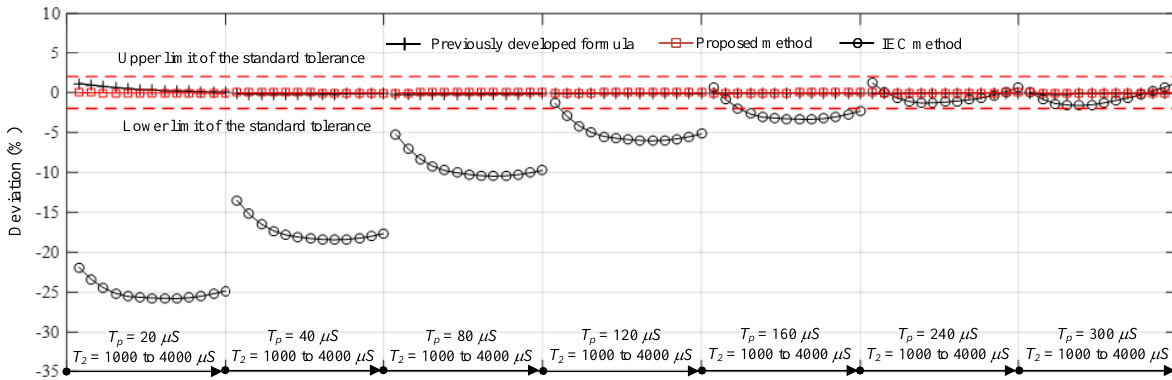
Figure 5. Comparisons of the computed times to crest by the proposed, standard, and previously developed formulas [1,16] and the standard tolerance